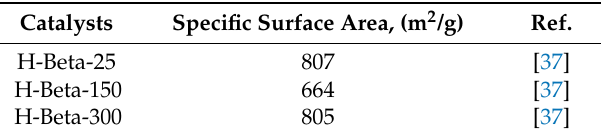
Table 1. Specific surface areas of catalysts studied for zeta potential measurements.